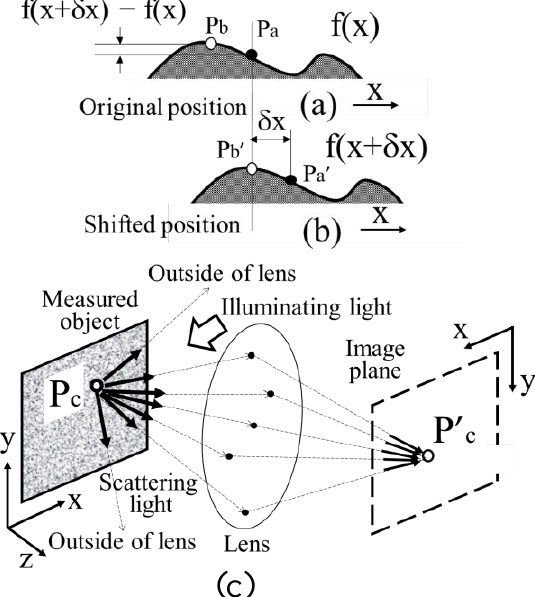
Figure 1. Principle of the measurement system. ( a ) Section of the measured object at the original position. ( b ) Section of the measured object at the shifted position. ( c ) Detection of two-dimensional phase distribution using the perfect optical system.